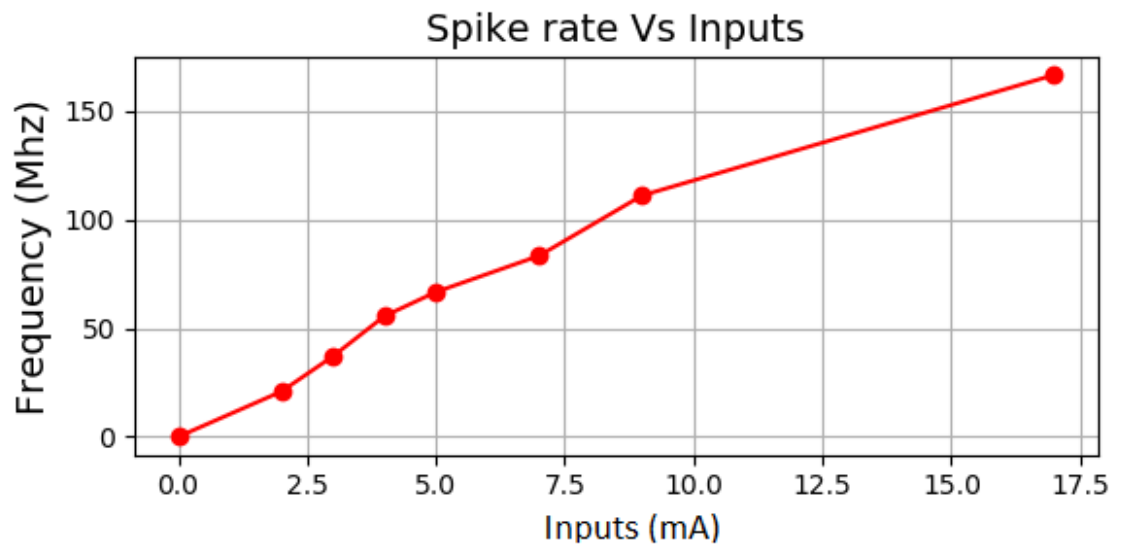
Figure 9. Spike rates of the proposed simpli fi ed LIF neuron in terms of di ff erent inputs ( 𝛼 = 0.937 and 𝛽 = 2).